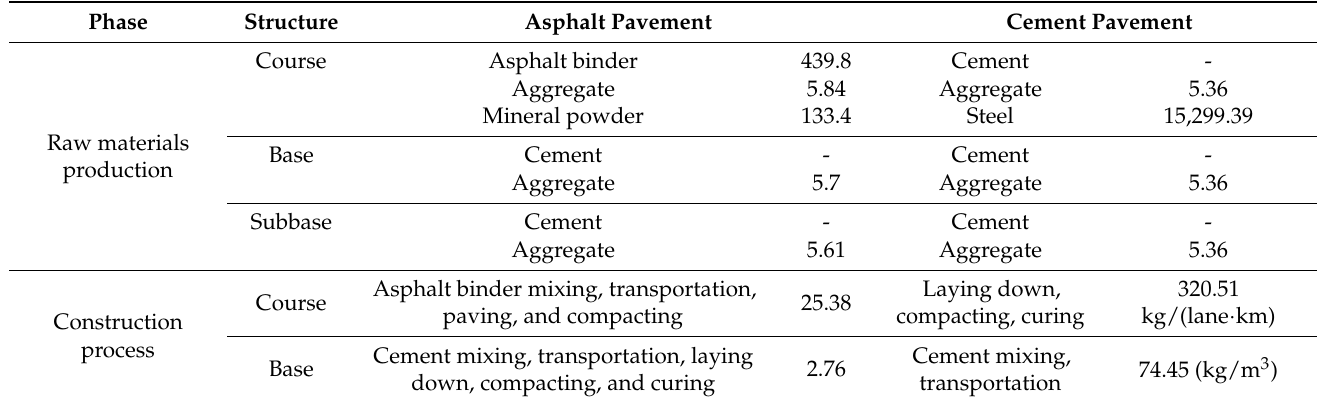
Table 2. Carbon emission factors of each pavement structure (units: kg/t).